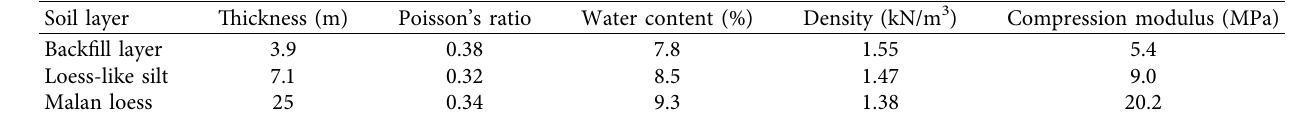
Table 1: Soil distribution and parameters.